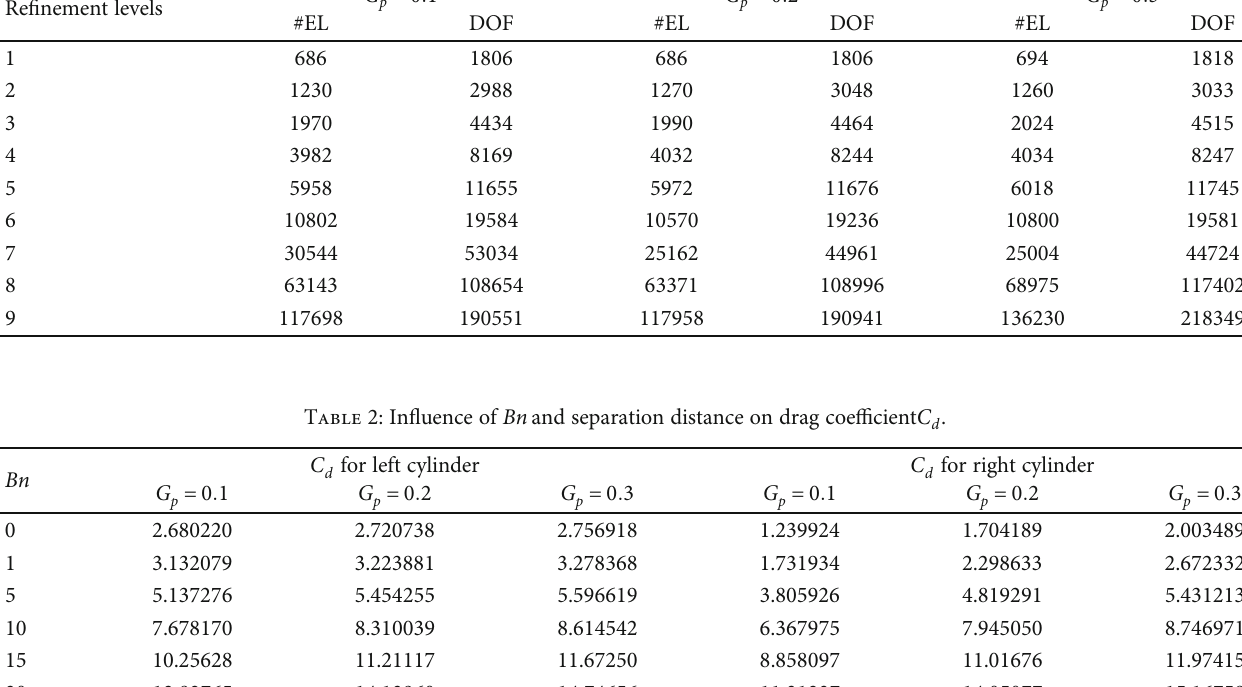
Table 1: Mesh statistics at di ff erent re fi nement levels.